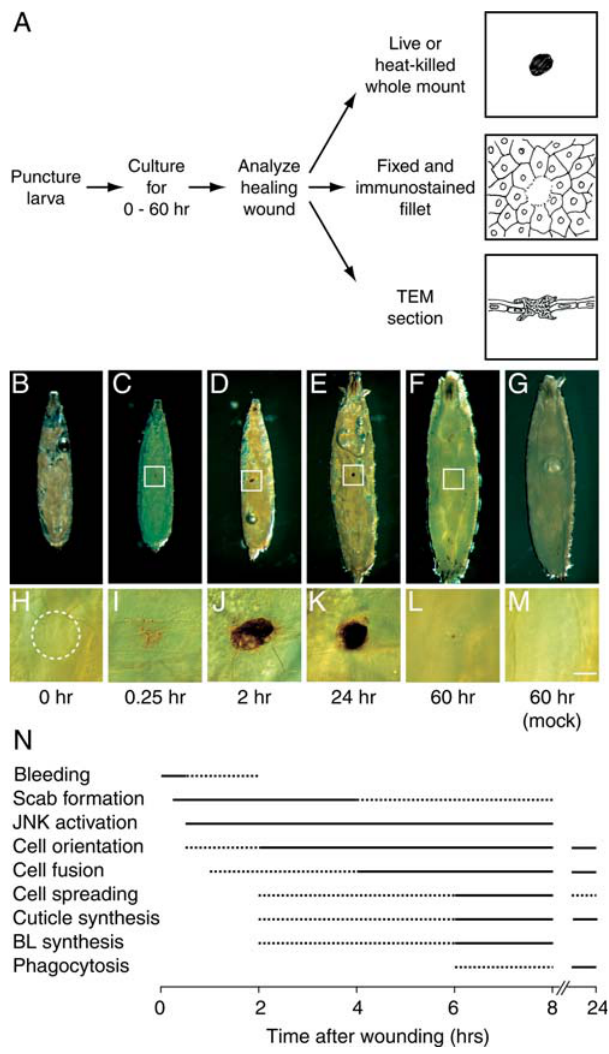
Figure 1. Scab Formation and Resolution during Puncture Wound Healing (A) Puncture wound assay. L3 larvae are punctured at the dorsal midline with a 100- l m diameter pin; they are then cultured and the healing wounds analyzed as shown. (B–E) Photomicrographs of heat-killed L3 larvae before wounding (B) and at the indicated times after wounding (C–E). Note larval growth during wound healing. Anterior is up. (F) L2 larva wounded as above and analyzed in L3, 60 h after wounding. Wounding in L2 allows visualization of late stages of wound healing without the complication of pupariation, which begins about 48 h after wounding in the standard L3 assay. (G) A mock-wounded L2 larva visualized 60 h after wounding. Note that it and the wounded larva (F) grew to a similar extent. (H–M) Close-up images of (B–G) showing unwounded cuticle (H and M) or wound sites (I–L, boxed regions in C–F) to show detail of scab. Micrographs are of living larvae taken shortly before the correspond- ing images of the whole heat-killed larvae above. Bar, 500 l m (for B– G), 50 l m (for H–M). (N) Timing of wound responses. Solid lines, time response was most often observed; dashed extensions to left, time response was occasionally observed; dashed extensions to right, time response was diminishing; BL, basal lamina. DOI: 10.1371/journal.pbio.0020239.g001